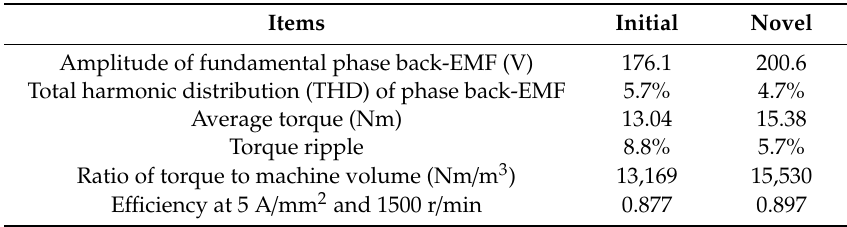
Table 2. Comparative results of the two FSPM